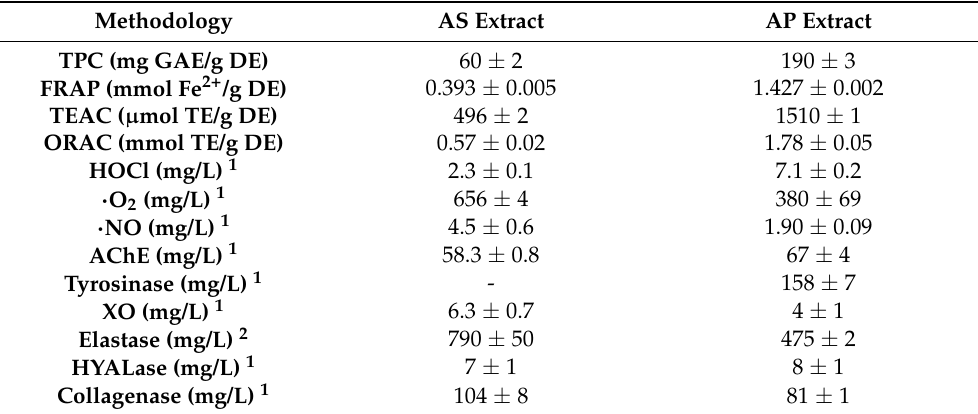
Table 3. Evaluation of total phenolic content, antioxidant capacity, radical scavenging and enzymatic inhibition of avocado by-product extracts. Methodology AS Extract AP Extract TPC (mg GAE/g DE) 60 ±